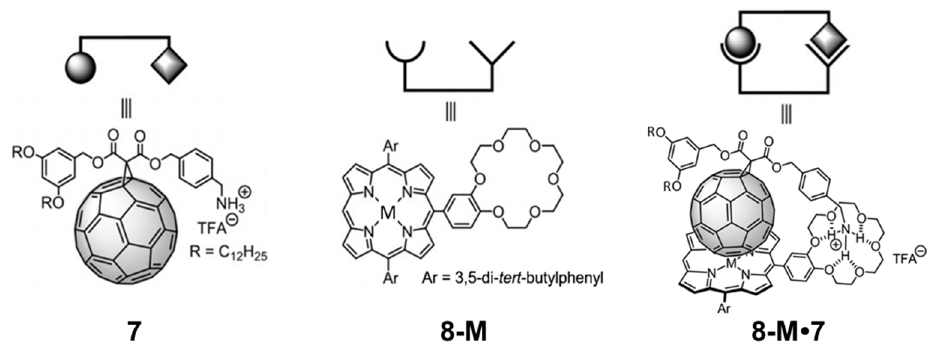
Figure 9. Chemical structure of the methano[60] fullerene guest 7 ( Left ), the metalloporphyrin host 8-M ( Center ), and the host–guest supramolecular complex 8-M • 7 ( Right ). M refers to either 2H, Co., Ni, Cu or Zn.